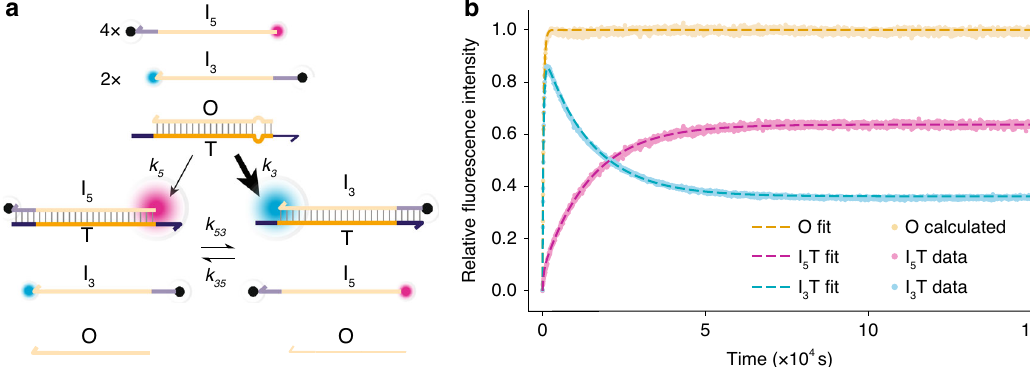
Fig. 6 Pulse generation with two-toehold competitive displacement reactions. a Schematic for two-toehold competitive displacement reaction with an asymmetrically placed mismatch in the substrate duplex OT , 18 bases from the 5 0 toehold and 3 bases from the 3 0 toehold. The 3 0 invading strand I 3 should be kinetically favoured. 5 0 invading strand I 5 is thermodynamically favoured as it is present in greater excess than I 3 , and both eliminate the initially present mismatch. b T – C → T – A mismatch elimination at position 18 from the 5 0 toehold of OT . Both processed data and ODE fi ts are shown for a single experiment (for fi tted parameters see Supplementary Table 1). Initial relative concentrations are [ I 5 ]:[ I 3 ]:[ OT ] = 4:2:1. Note that the O curve is inferred from the sum of I T and I T , with its maximum value used to scale the fi gure (see Supplementary Note 3.2). 3 5